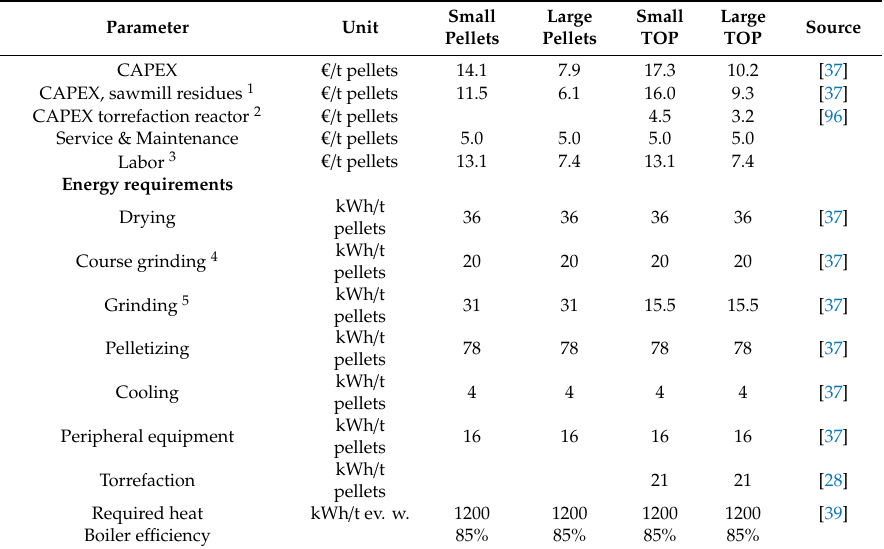
Table A6. Pelletizing costs and GHG factors, for a small (50 kt / y) and large (500 kt / y) pellet mill in the United States, based on data from Visser et al.